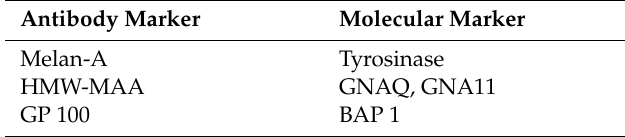
Table 1. main targetable antibody and molecular markers of uveal